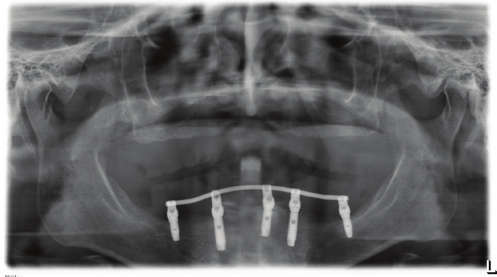
Figure 14: Panoramic X-ray after one-year